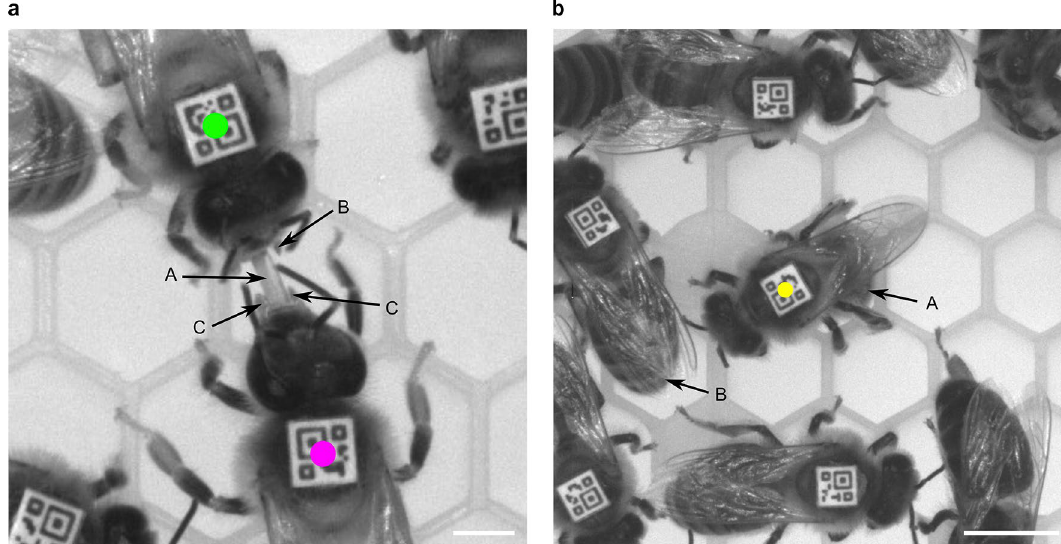
Figure 1. Examples of trophallaxis and egg-laying, illustrating the stark differences between these two behaviors. ( a ) In honey bees, trophallaxis is a social behavior during which two individuals orally